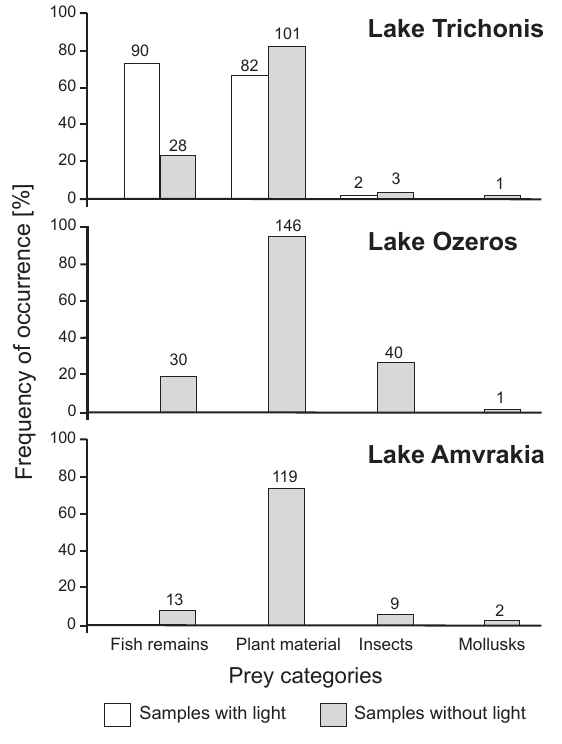
Figure 2. The overall frequency of occurrence of the main food types found in the gut contents of the Scardinius acarnanicus specimens collected in Lake Trichonis (separately for the sam- ples taken with or without light), Lake Ozeros and Lake Am- vrakia. The numbers of the Scardinius acarnanicus individuals with the specific type of food are given.